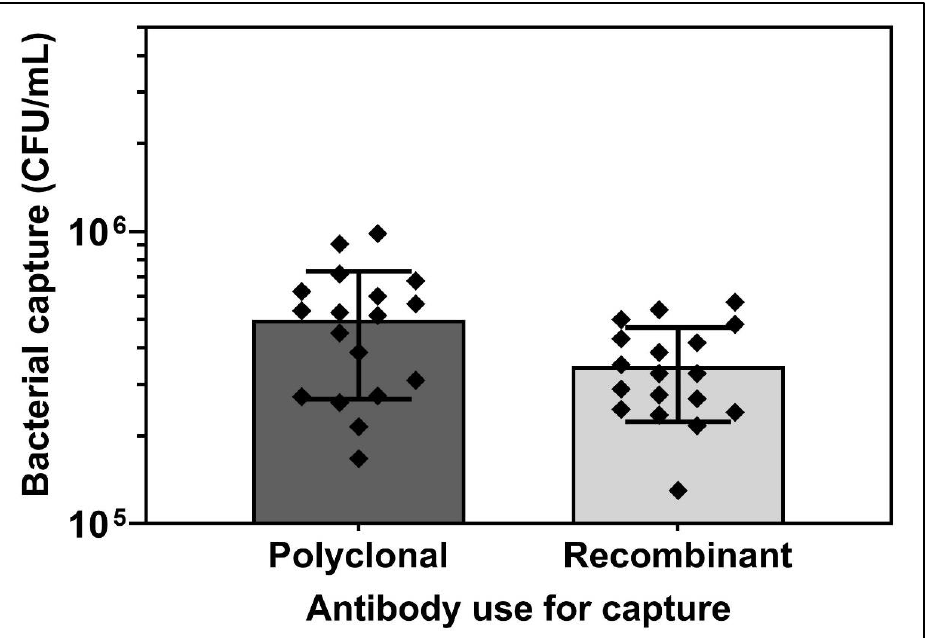
Figure 6. Compilation of number of L. pneumophila captured in wells coated with pAb ( left ) and recAb ( right ) exposed to 10 7 CFU/mL L. pneumophila from Figure 5. Data were quantified with qPCR by employing 16S rDNA universal primers. Error bars are shown to indicate standard deviation.